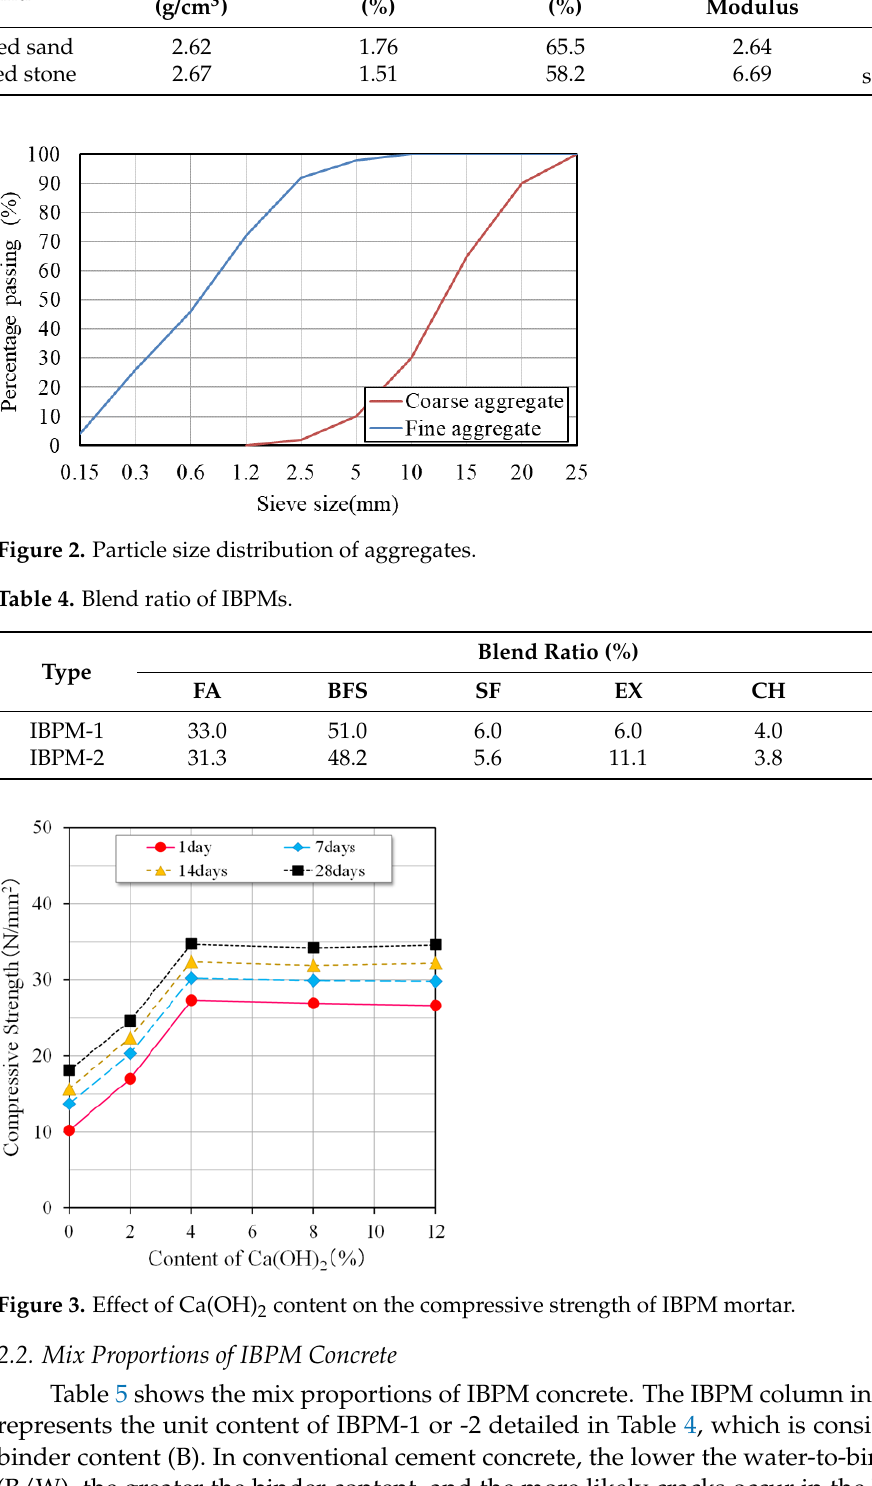
Figure 1. Particle size distribution of materials for IBPM. Table 3. Aggregate properties for IBPM concrete.